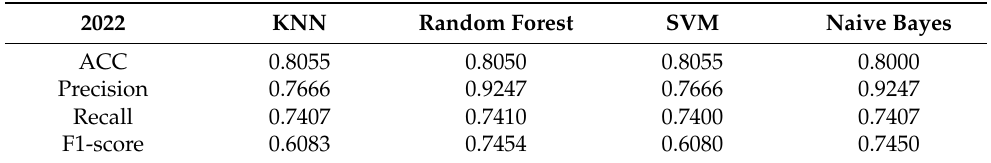
Table 6. Results from complex forecasting models for sequential feature extraction from data for 2022, without feature selection.